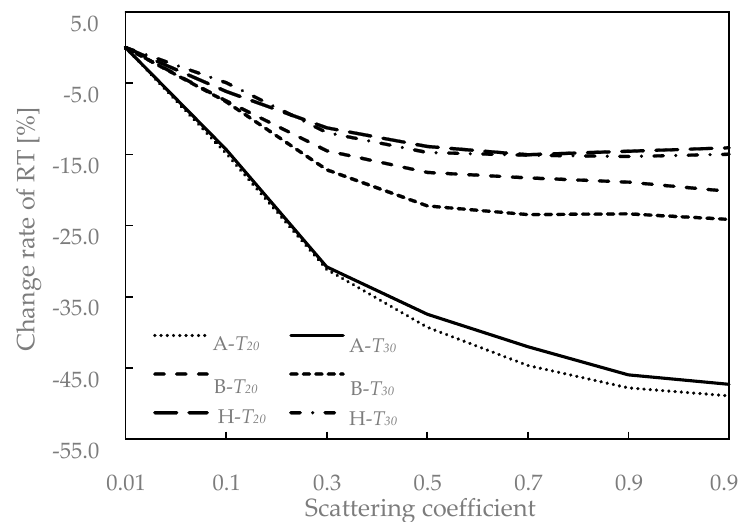
Figure 2. Comparison of the T20 and T30 change rates in Spaces A, B, and H at 2000 Hz. Note: A: rectangular space, B: single sidewall tilted, and H: both sidewalls and ceiling are tilted at the same time.